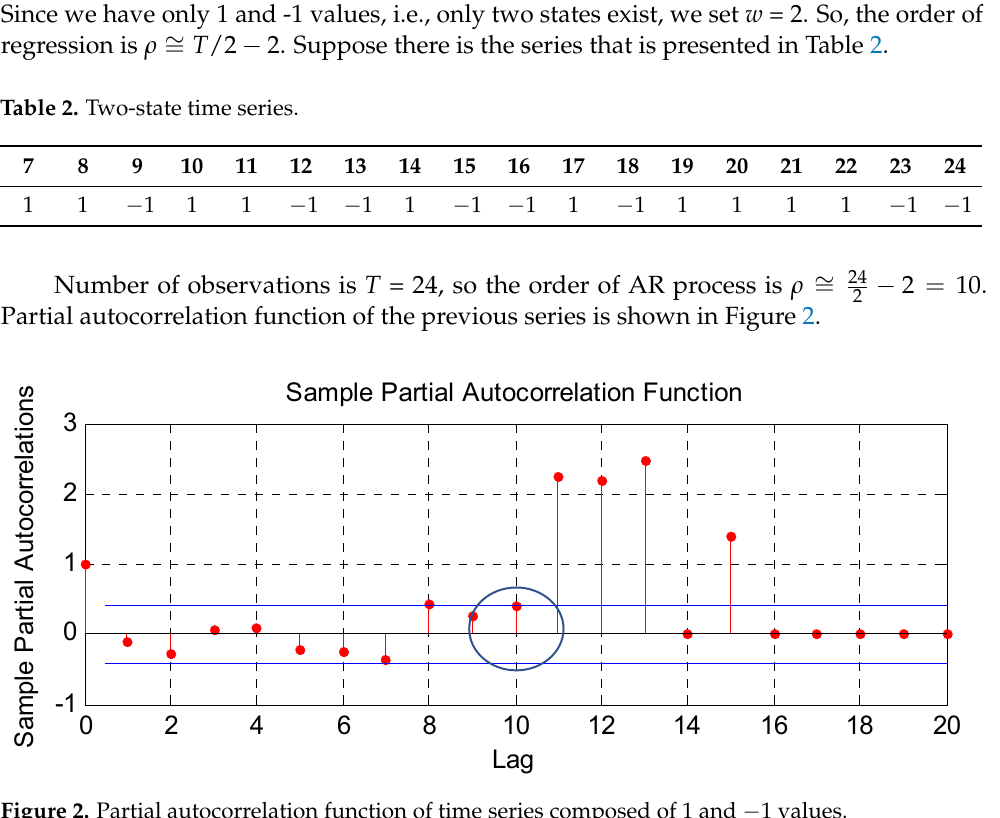
Figure 2. Partial autocorrelation function of time series composed of 1 and − 1 values. According to the modified approach, we can see that Lag10 can be used as order of AR process, so ρ = 10. Coefficients β 0 , β 1 , β 2 , . . . , β 10 are presented in Table 3. Table 3. Coefficients of AR(10) process.